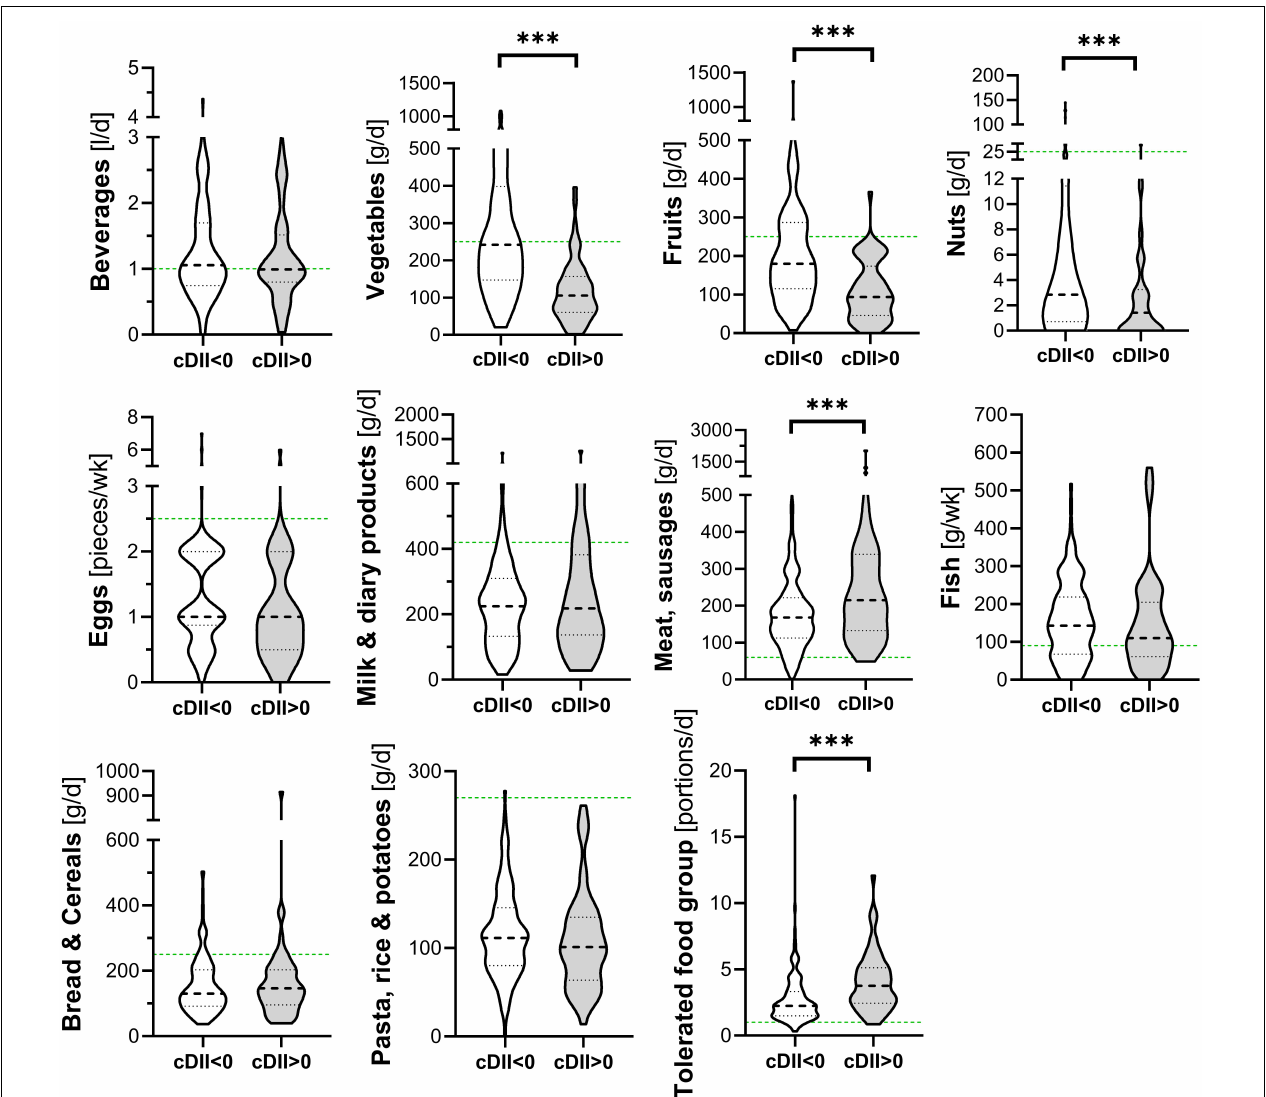
FIGURE 2 | Food groups and C-DII. Children’s consumed food groups at the age of 10 years according to having a pro (C-DII > 0) or anti-inflammatory (C-DII < 0) diet at the age of 10 years. Green line: OptiMix recommendations for 10–12 year old children (26). Data are presented as violin plots with median (bold dotted line) and 25 to 75th percentile (dotted line), n = 211. ∗∗∗ Significant difference ( p < 0.05) by Mann–Whitney U